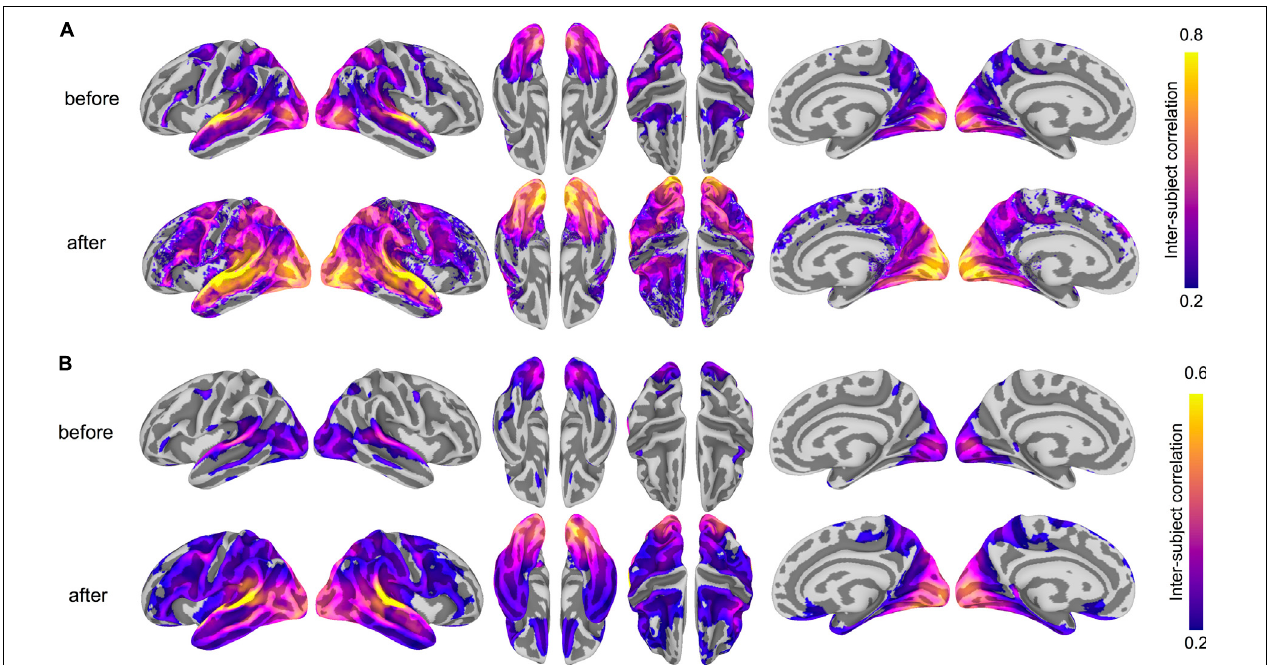
FIGURE 2 | Hyperalignment improves inter-subject correlation (ISC) of response profiles and representational geometry. (A) ISC of vertex-wise response time series before and after hyperalignment. Colored vertices reflect the mean ISC across subjects, thresholded at a mean correlation of 0.2. ISCs are highest in the superior temporal gyrus (in the vicinity of auditory cortex), as well as the dorsal and ventral visual pathways, comprising early visual, lateral occipitotemporal, ventral temporal, posterior parietal, and intraparietal cortices. (B) ISC of searchlight representational geometries (time-point RDMs in 9 mm radius searchlights) before and after hyperalignment. Colored vertices reflect the mean pairwise correlation across subjects for each searchlight, thresholded at a mean correlation of 0.2, revealing a broader extent of cortex with improved alignment of functional topography after hyperalignment. ISCs were Fisher z -transformed before averaging across all subjects and inverse Fisher transformed before mapping onto the cortical surface for visualization. All maps are rendered on the fsaverage6 surface